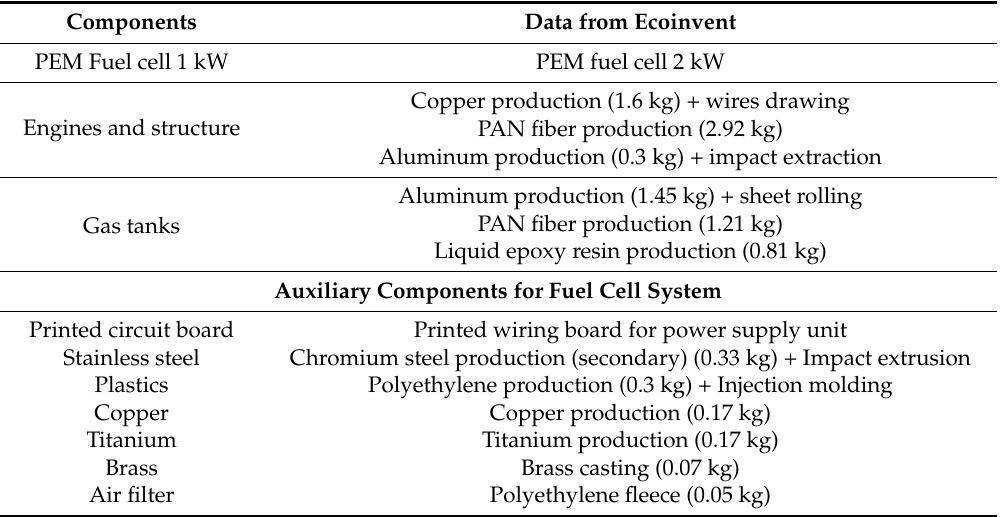
Table 5. Inventory for the fuel cell-based mobile system.